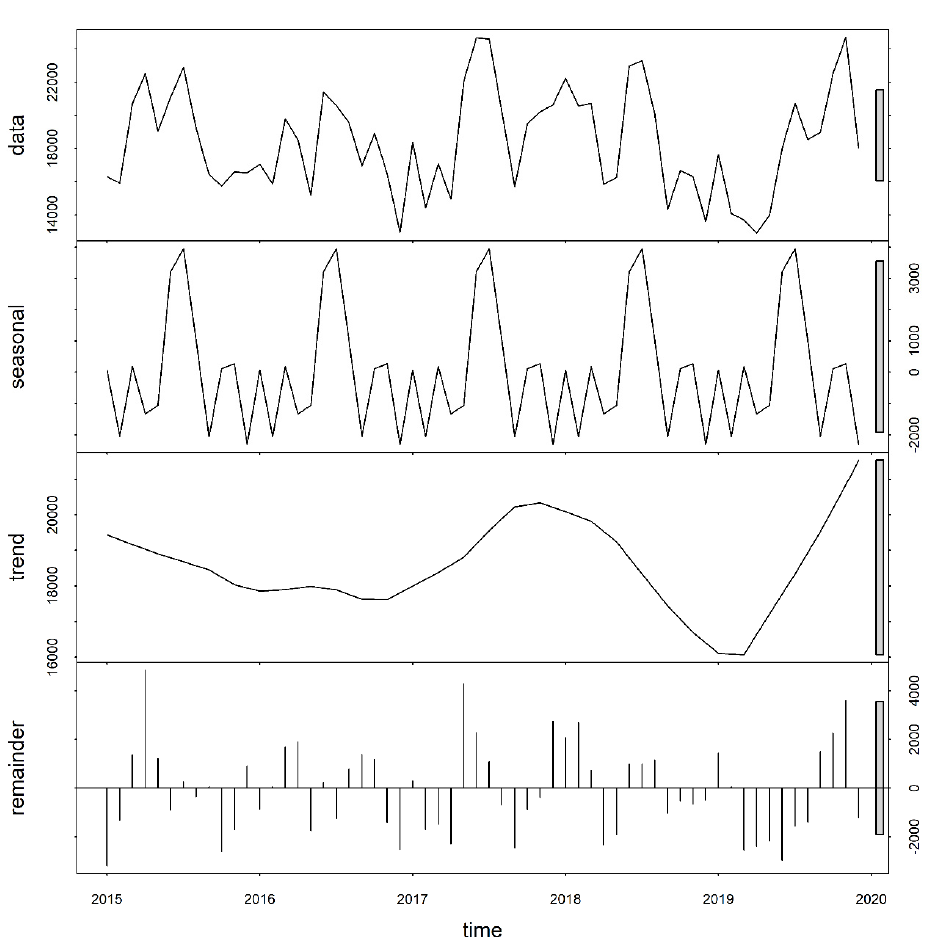
Figure 3. Temporal decomposition of numbers of malaria cases for the Greater Accra Region, 2015–2019. Source: Authors’ own contributions. Table 3. Regression coefficients, relative risk, and 95% credible interval from Bayesian spatial and non-spatial models of malaria in the Greater Accra Region, Ghana, January 2015–December 2019.